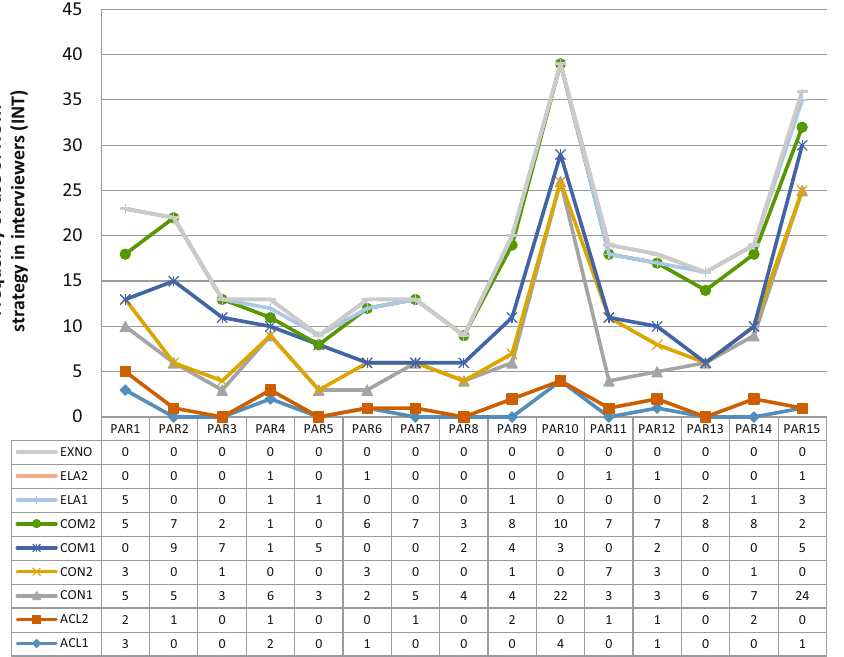
Figure 3: NOM strategies used by interviewers in the oral test of LETRA diploma.